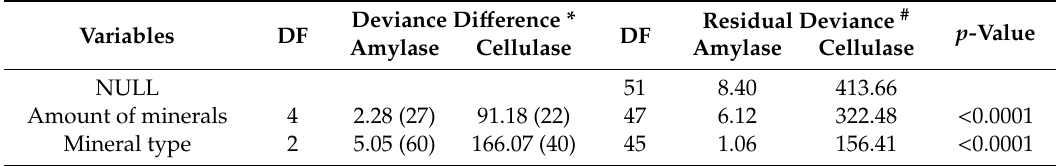
Table 2. Summary statistics of the generalized linear model (GLM) for the variation in the protein content measured for amylase and cellulase in the treatments, with or without soil mineral addition. Significance was assessed by using likelihood ratio tests. Numbers in parentheses indicate the percentage of variation explained by the respective